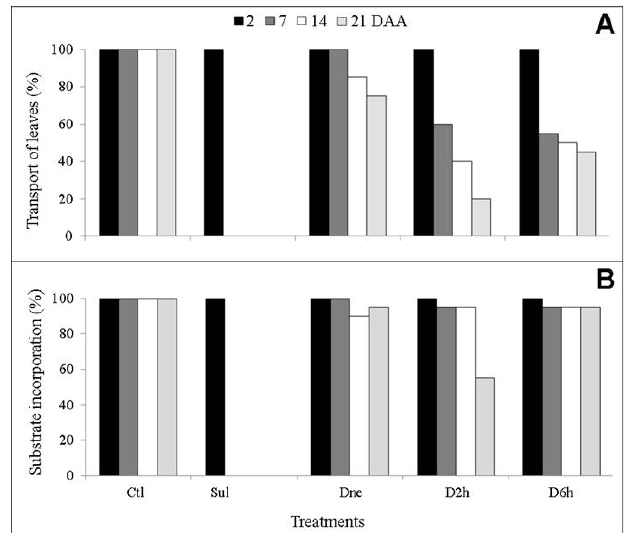
Fig 1 . Transport of Acalypha leaves (A) and substrate incorporation (B) by A. sexdens rubropilosa workers after application of baits. Treatments: Ctl (control); Sul (sulfluramid); Dne (diafenthiuron no exposure to ultraviolet light), D2h (diafenthiuron with 2h exposure to ultraviolet light); D6h (diafenthiuron with 6h exposure to ultraviolet light). DAA (days after application).